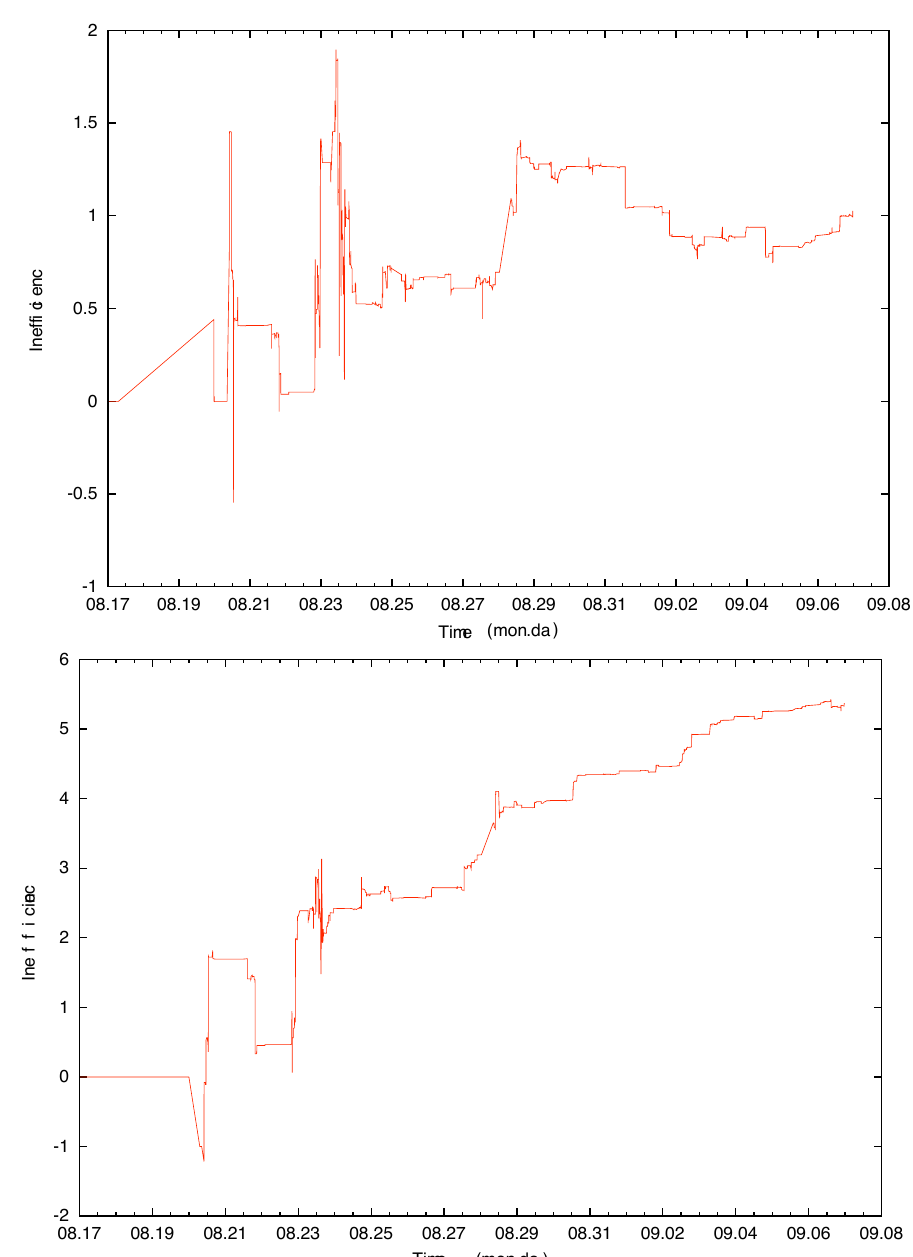
Figure 3. Inefficiency I ij ( t ,0 ) for two agent groups in the in-sample (first half) set. On the ( top ), two randomly chosen groups and on the ( bottom ) the decile of agents with the highest ETR against the rest of the